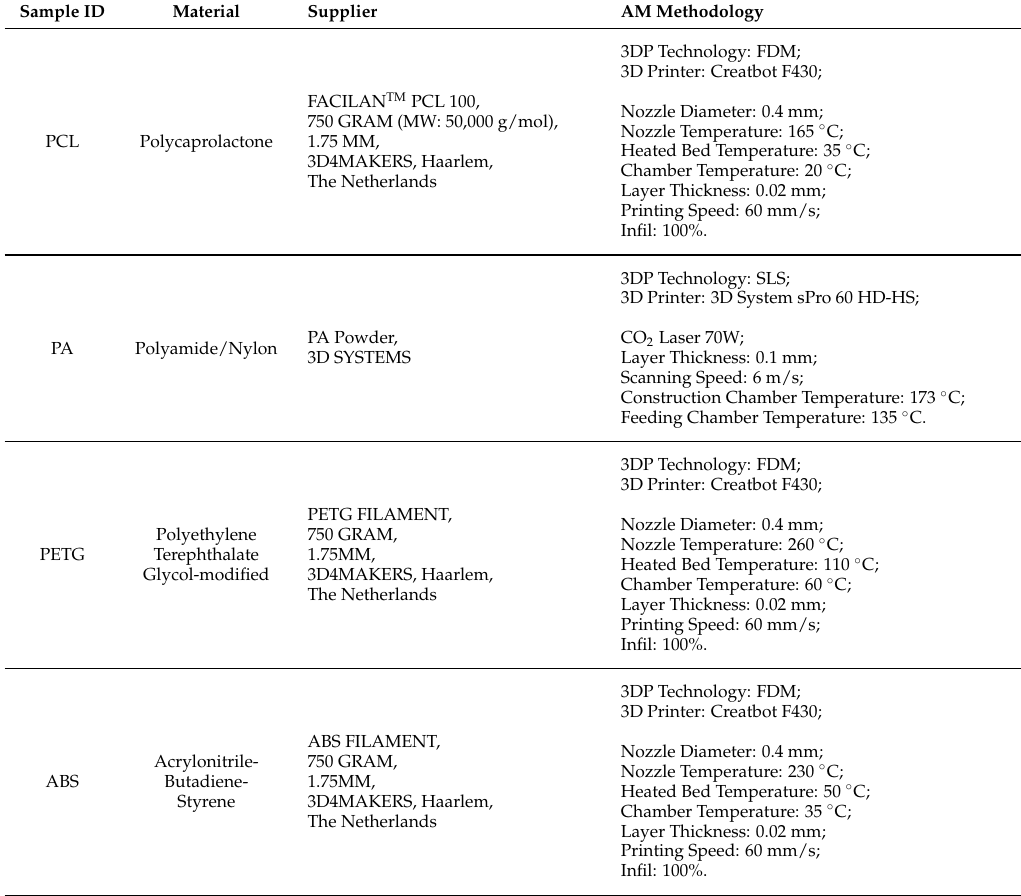
Table 1. Description of sample identity (ID) and material, correspondent supplier and AM